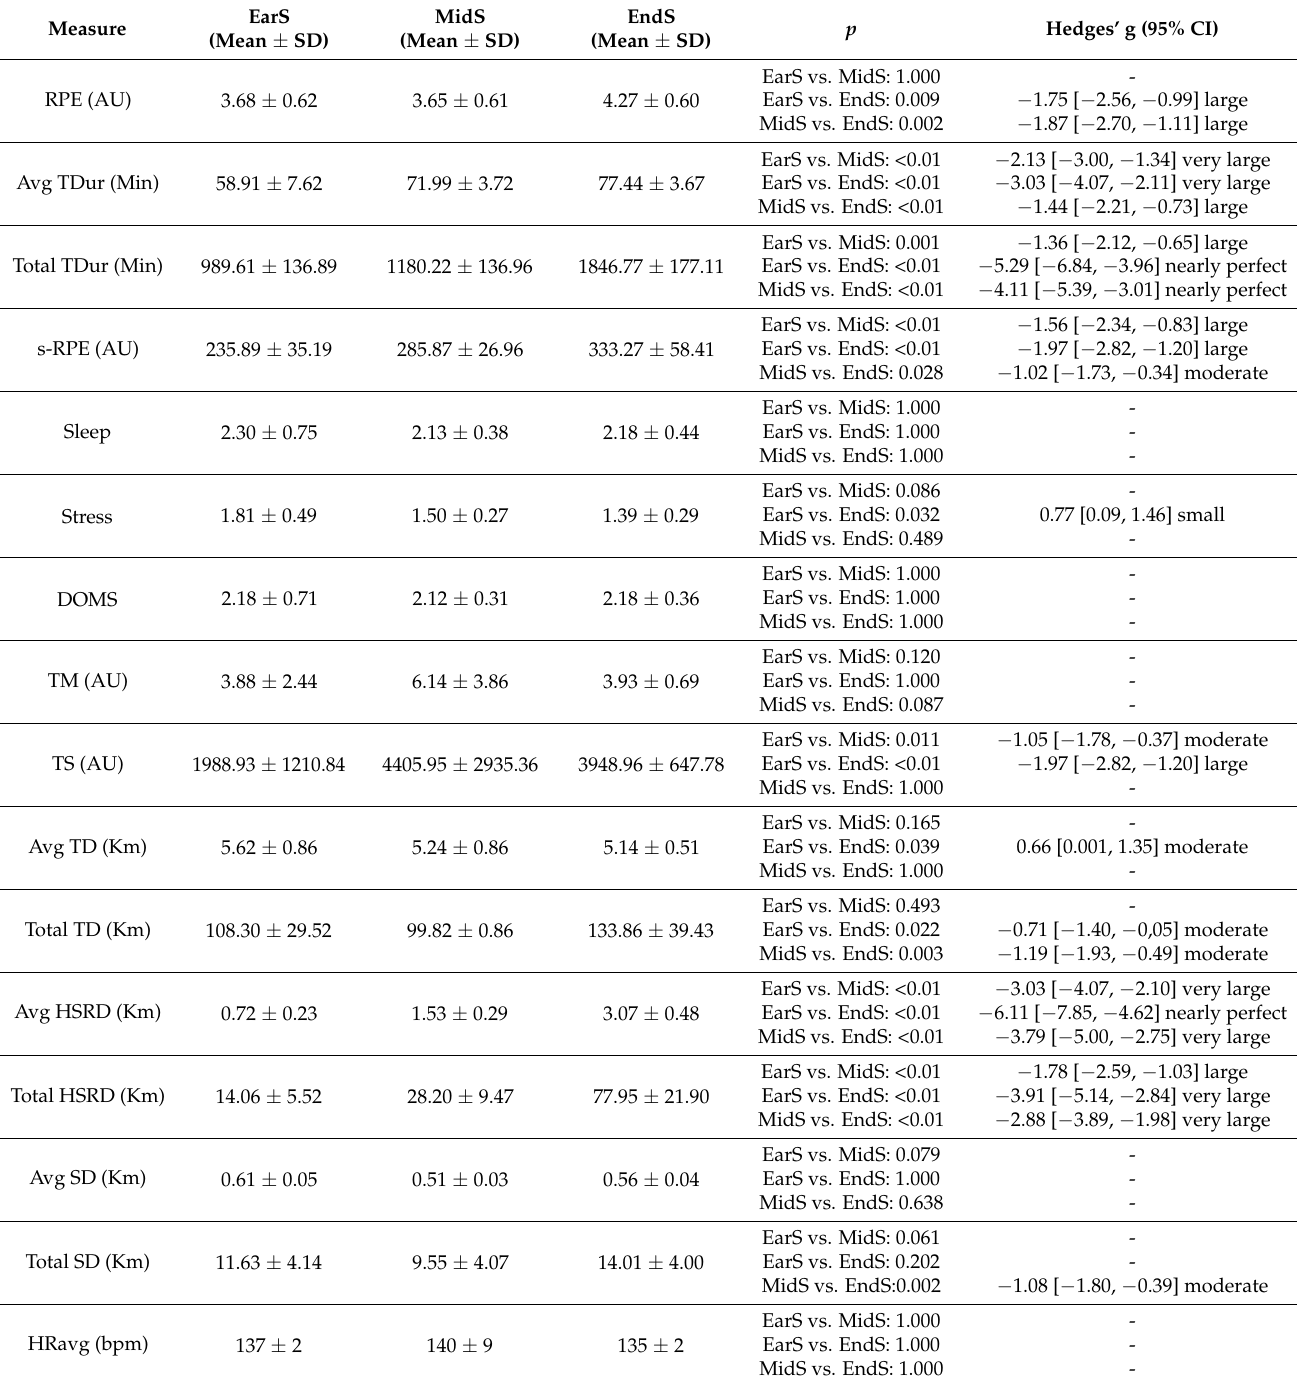
Table 1. Descriptive statistics (mean ± standard deviation (SD)) of the external, and internal and well-being measures in the early-, mid- and